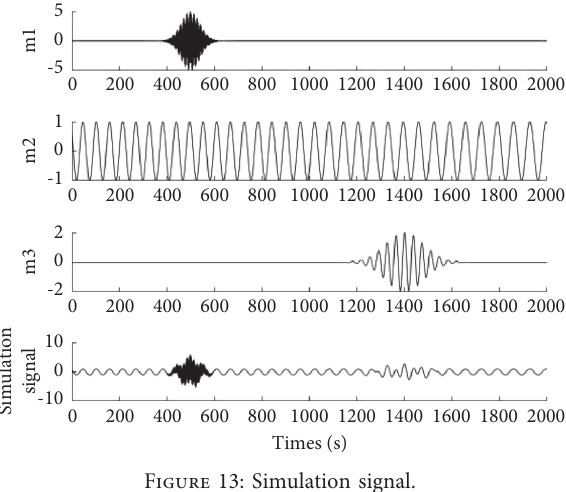
Figure 13: Simulation signal.